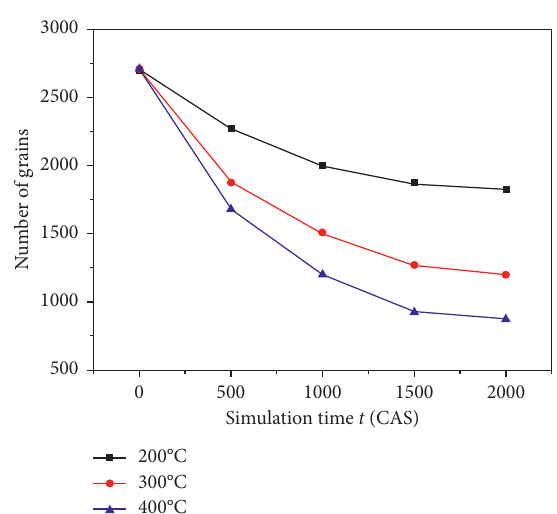
Figure 7: Number of grains at different